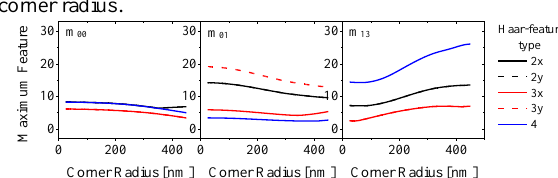
Fig. 2. Measurement (left) and simulation (right) of Mueller matrix images for a 5 µm sized square structure with 400 nm corner radius.